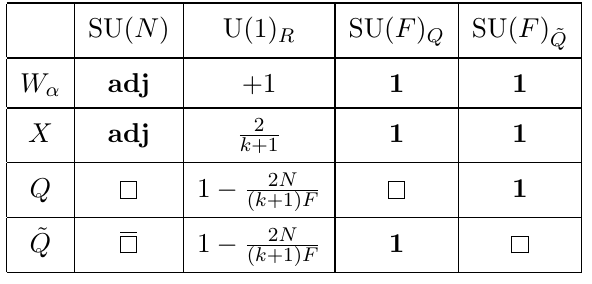
Table 3 . Quantum numbers of fields in the electric SU( N ) SQCD with an adjoint.